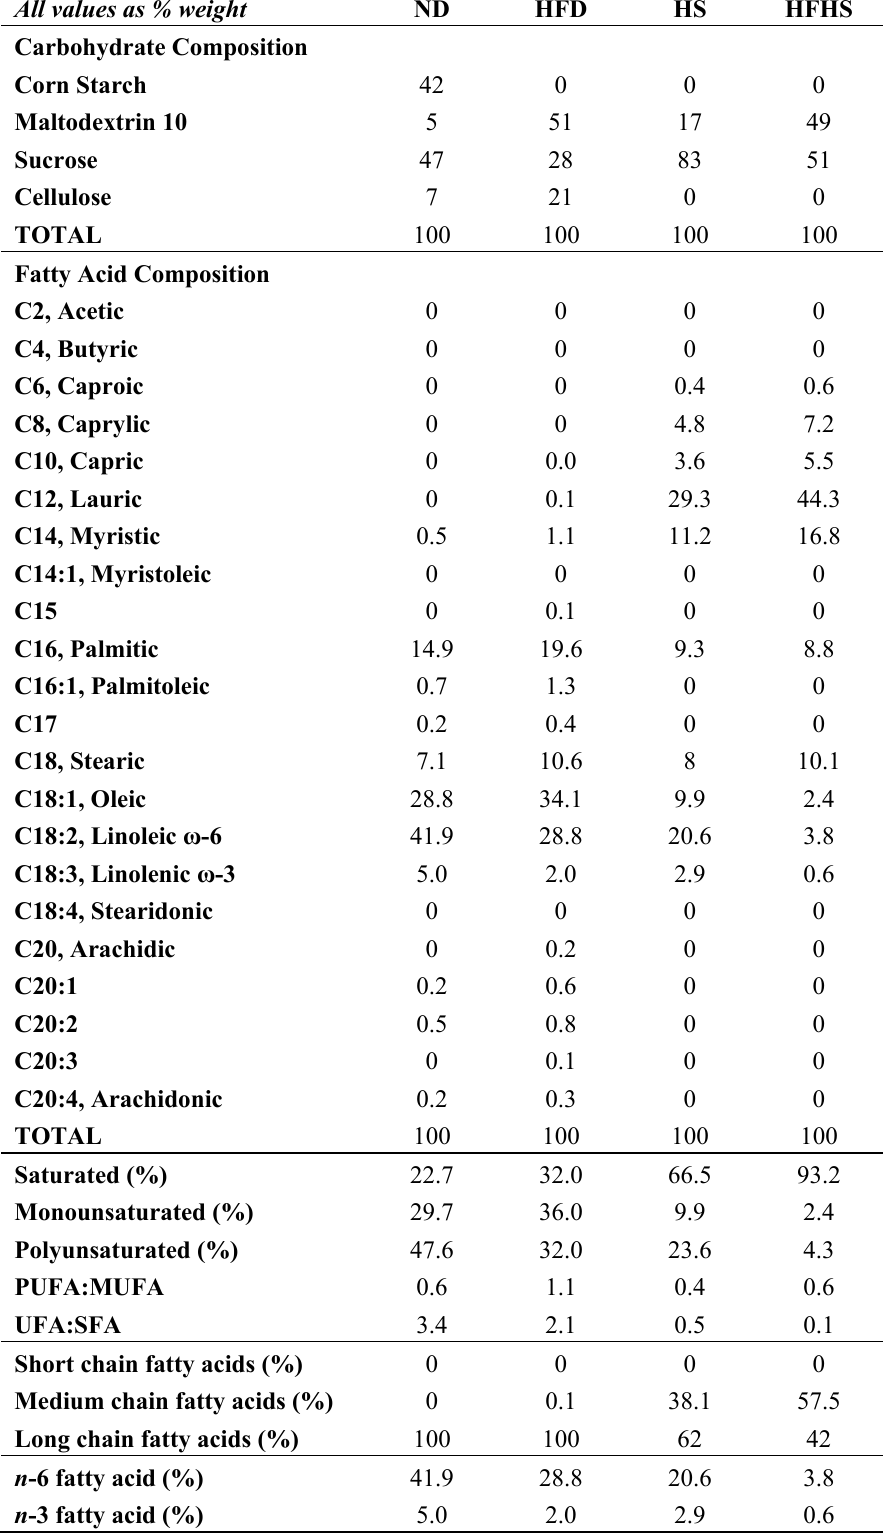
All values in the table represent the percentage of the total dry weight of the diet for the indicated carbohydrate or